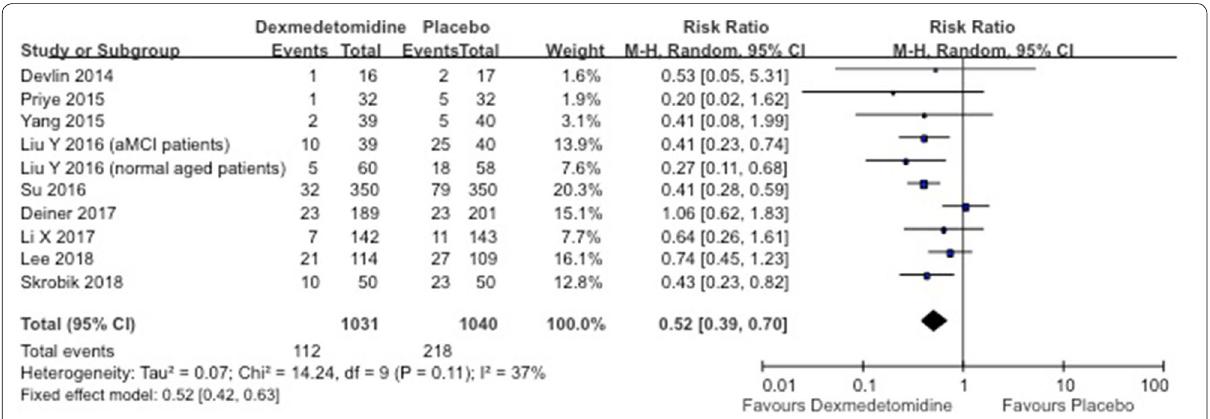
Fig. 2 Forest plot for incidence of delirium in placebo-controlled RCTs. aMCI amnestic mild cognitive